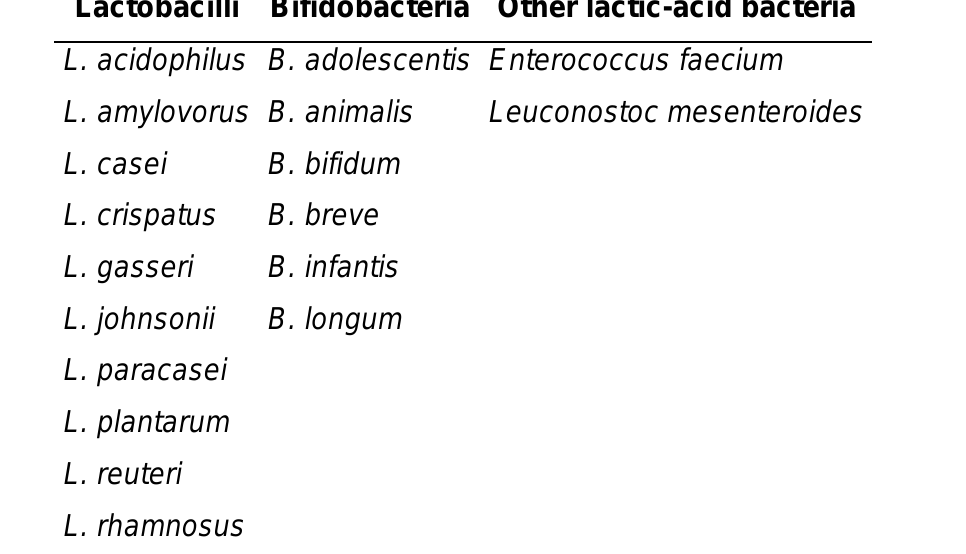
Table 2: Microorganisms considered